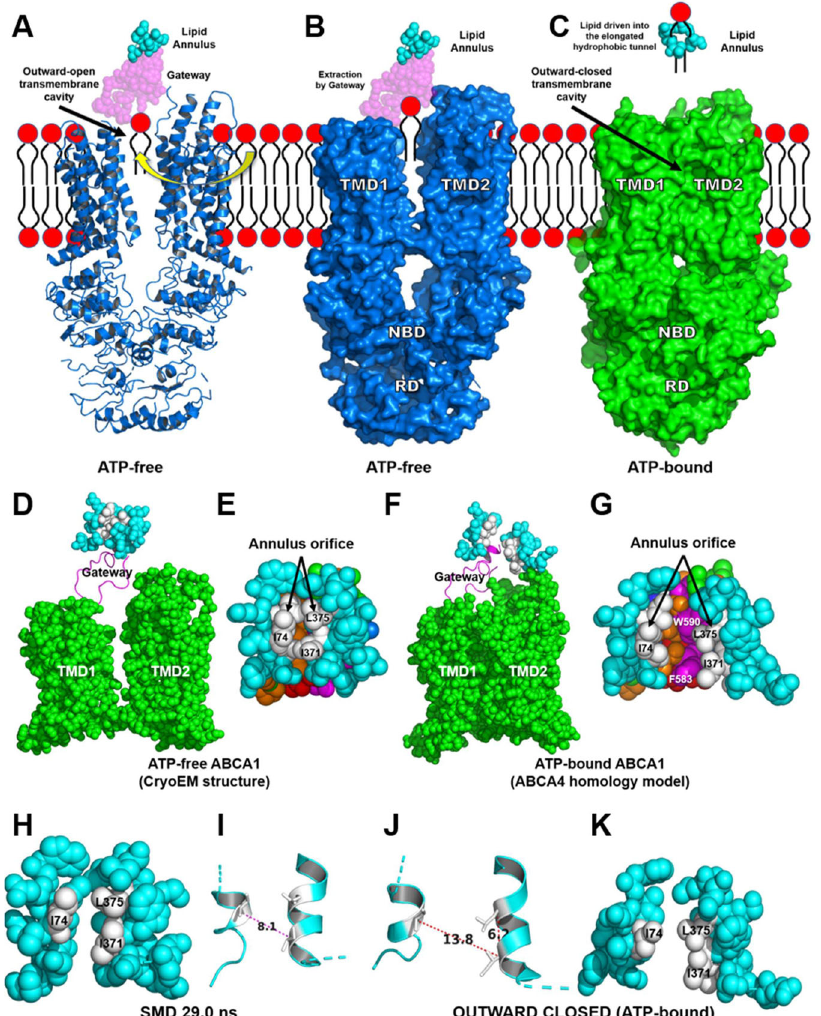
Fig. 6 | The structures of ATP-free ABCA1 determined by cryo-EM and ATP- boundABCA1basedonhomologymodelingwithABCA4.A Cartoonofthecryo- EM determined NBDs, cytoplasmic regulatory domains (RDs), TMDs, gateway and lipid annulus of ATP-free ABCA1 13 . POPC has diffused into the outward-facing transmembrane cavity from the outer cell membrane monolayer. B Surface representation of the portion of ABCA1 shown in panel A. PC extracted by the gateway is pulled from the outer lea fl et of the plasma membrane. C Surface representation of ATP-bound ABCA1 derived from a homology model of ATP- bound ABCA4 (the power stroke). The outward-facing cavity of ABCA1 is in the outward-closed conformation. Closure of the cavity drives extracted lipid through theannulusintotheelongatedhydrophobictunnel.Theannulusori fi